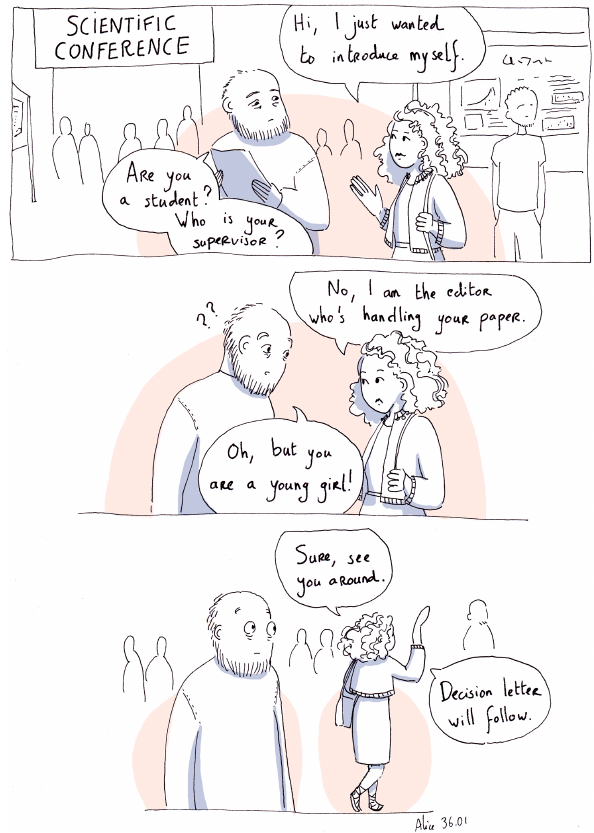
Figure 3. “Who’s your advisor?” comic strip that falls into the “Fe- male stereotypical roles” category. In this case, a female is consid- ered at lower grade based on her appearance and gendered condition (DTRH team, 2019a; Adenis, 2019). All comics are hand-drawn by Alice Adenis – distributed under the Creative Commons Attribution 4.0 License.